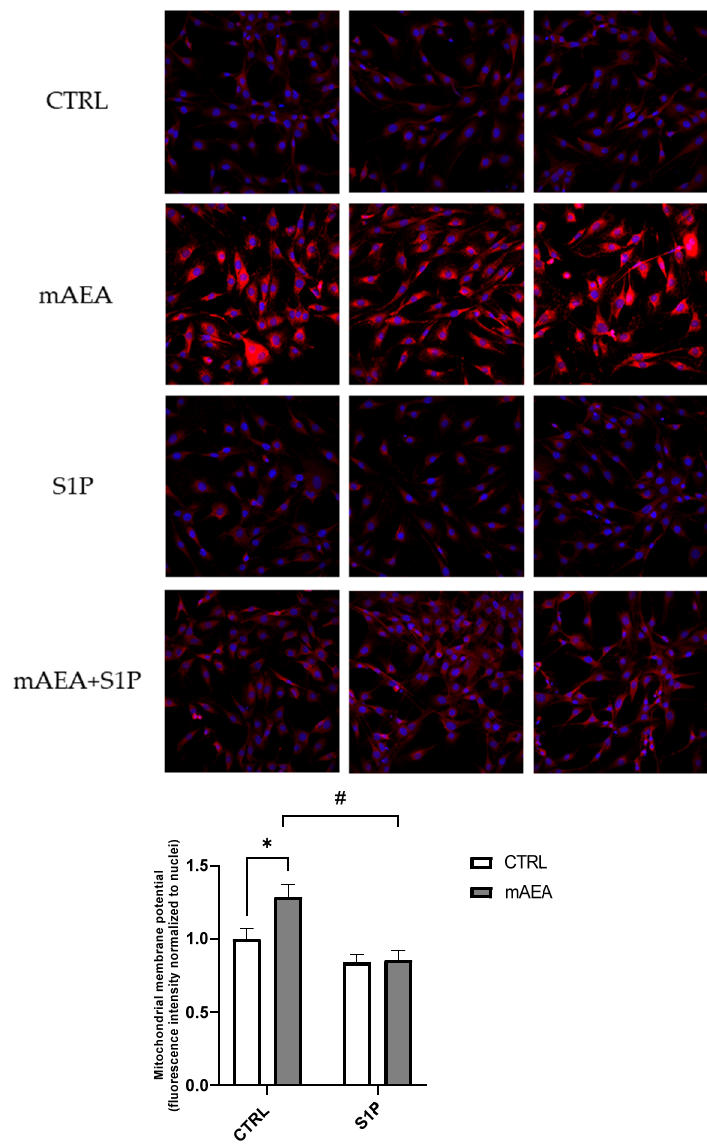
Figure 9. Effect of S1P on mAEA-induced mitochondrial membrane potential in C2C12 myoblasts. Confluent serum-starved cells were treated with 5 µ M mAEA in the presence or absence of 1 µ M S1P for 24 h. Fluorescence intensity of Mitotracker Red CMX-Ros (Ex/Em: 579/599) was normalized to cell number and data are reported as mean ± SEM of six field per condition in three independent experiments. Statistical analysis was performed by TWO-WAY ANOVA followed by Bonferroni post-hoc test [* p < 0.05 mAEA vs CTRL, # p < 0.05 S1P+mAEA vs mAEA].